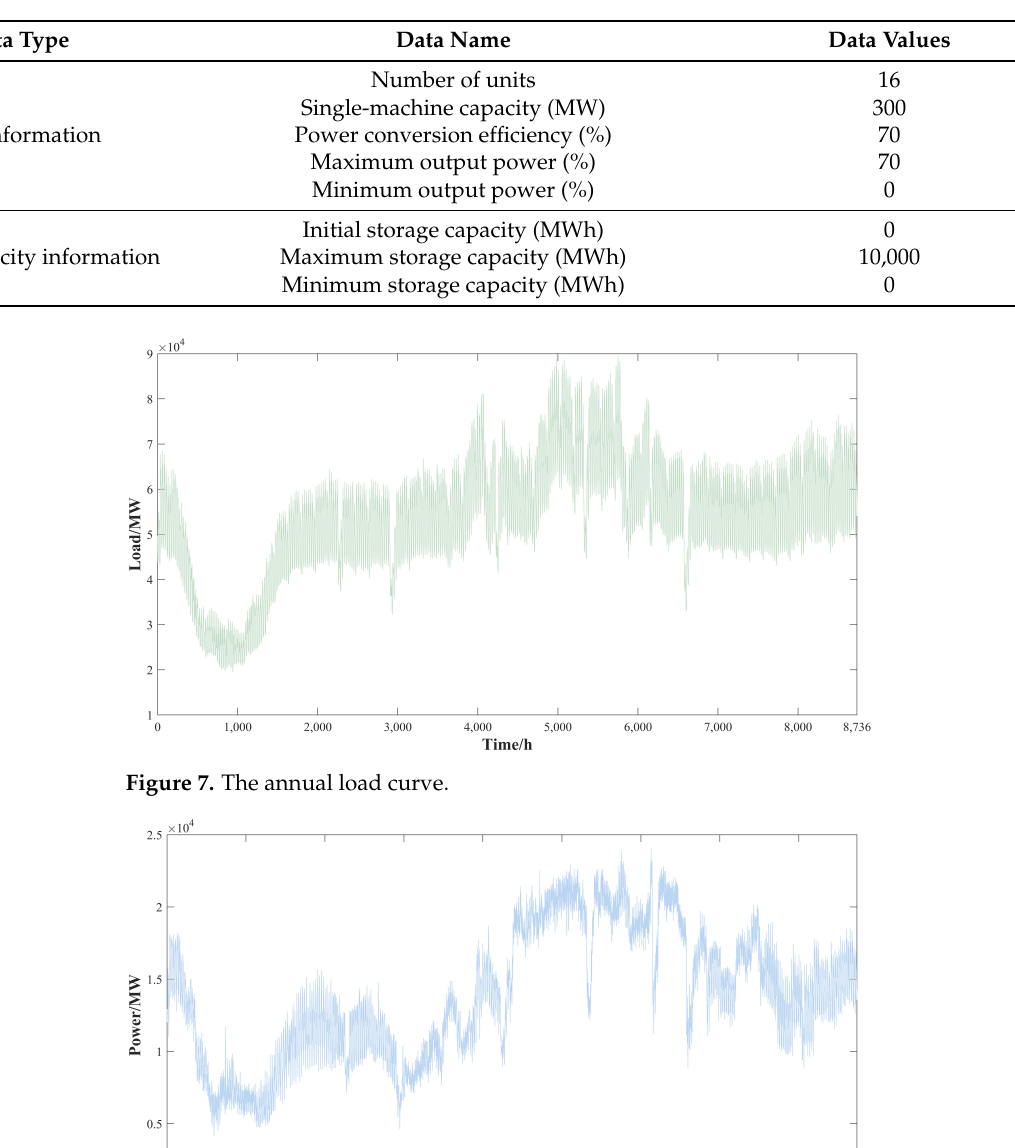
Table 3. The configuration information of pumped storage power station.